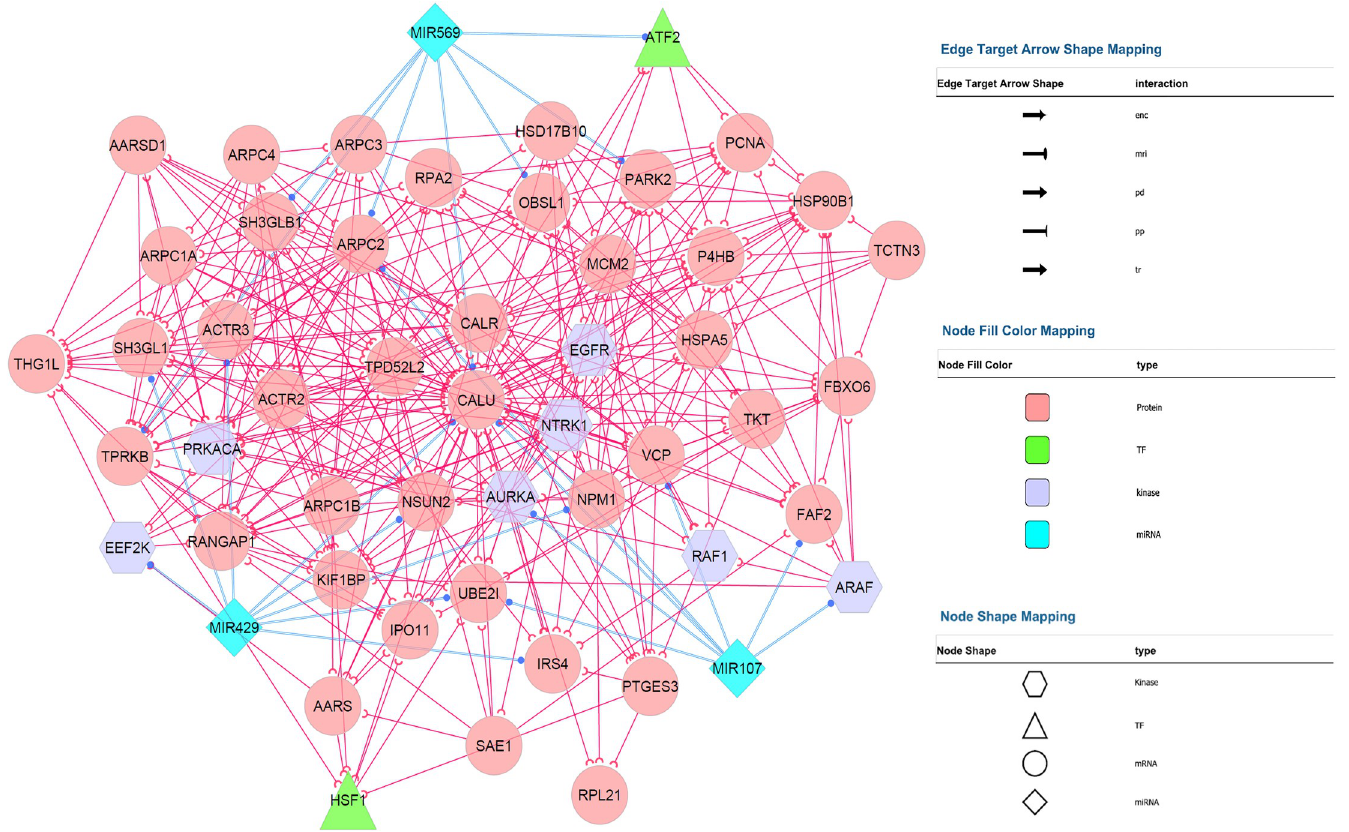
Fig 1. Construction of calumenin co-expressed genes network. The network was visualized using the Cytoscape plugins BisoGenet and CentiScaPe.